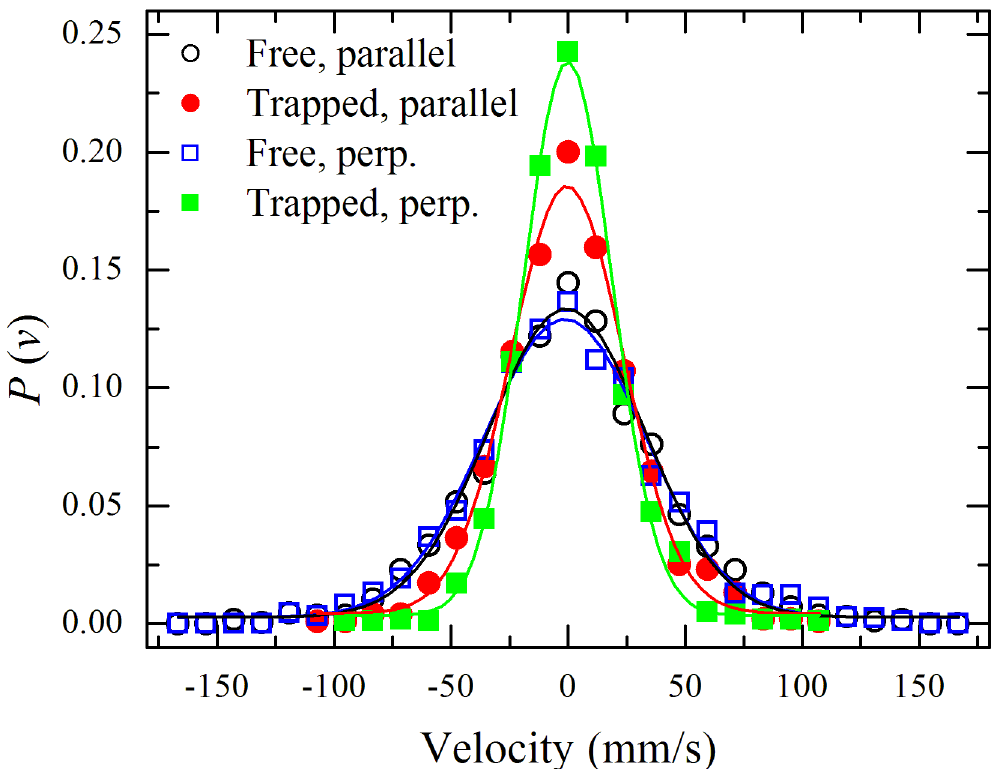
Fig 3. Probability distributions for velocity components along parallel (circles) and perpendicular (squares) directions to the confining rods for IDA configurations. Solid symbols represent sandwiched spheres. Hollow symbols represent free particles. Lines represent best fit to Gaussian